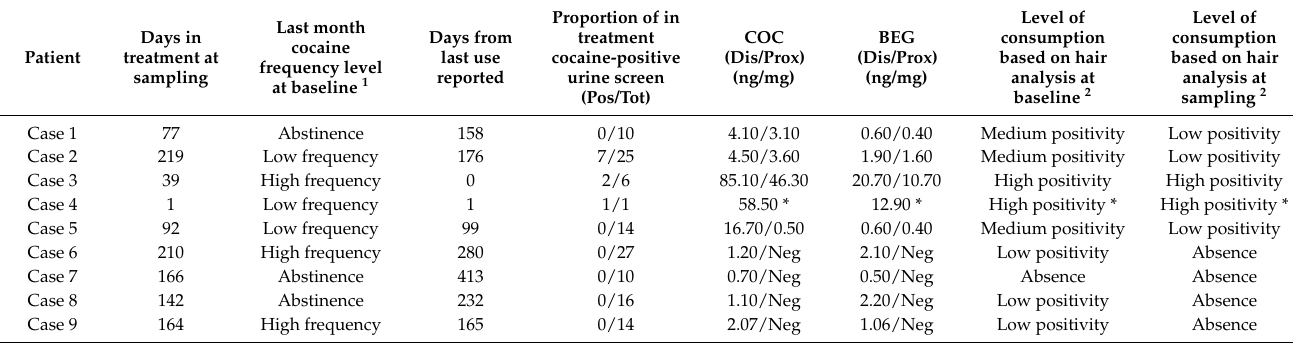
Table 4. Cocaine urine screen and pre–post treatment hair analyses outcomes in CocUD patients undergoing rTMS treatment.